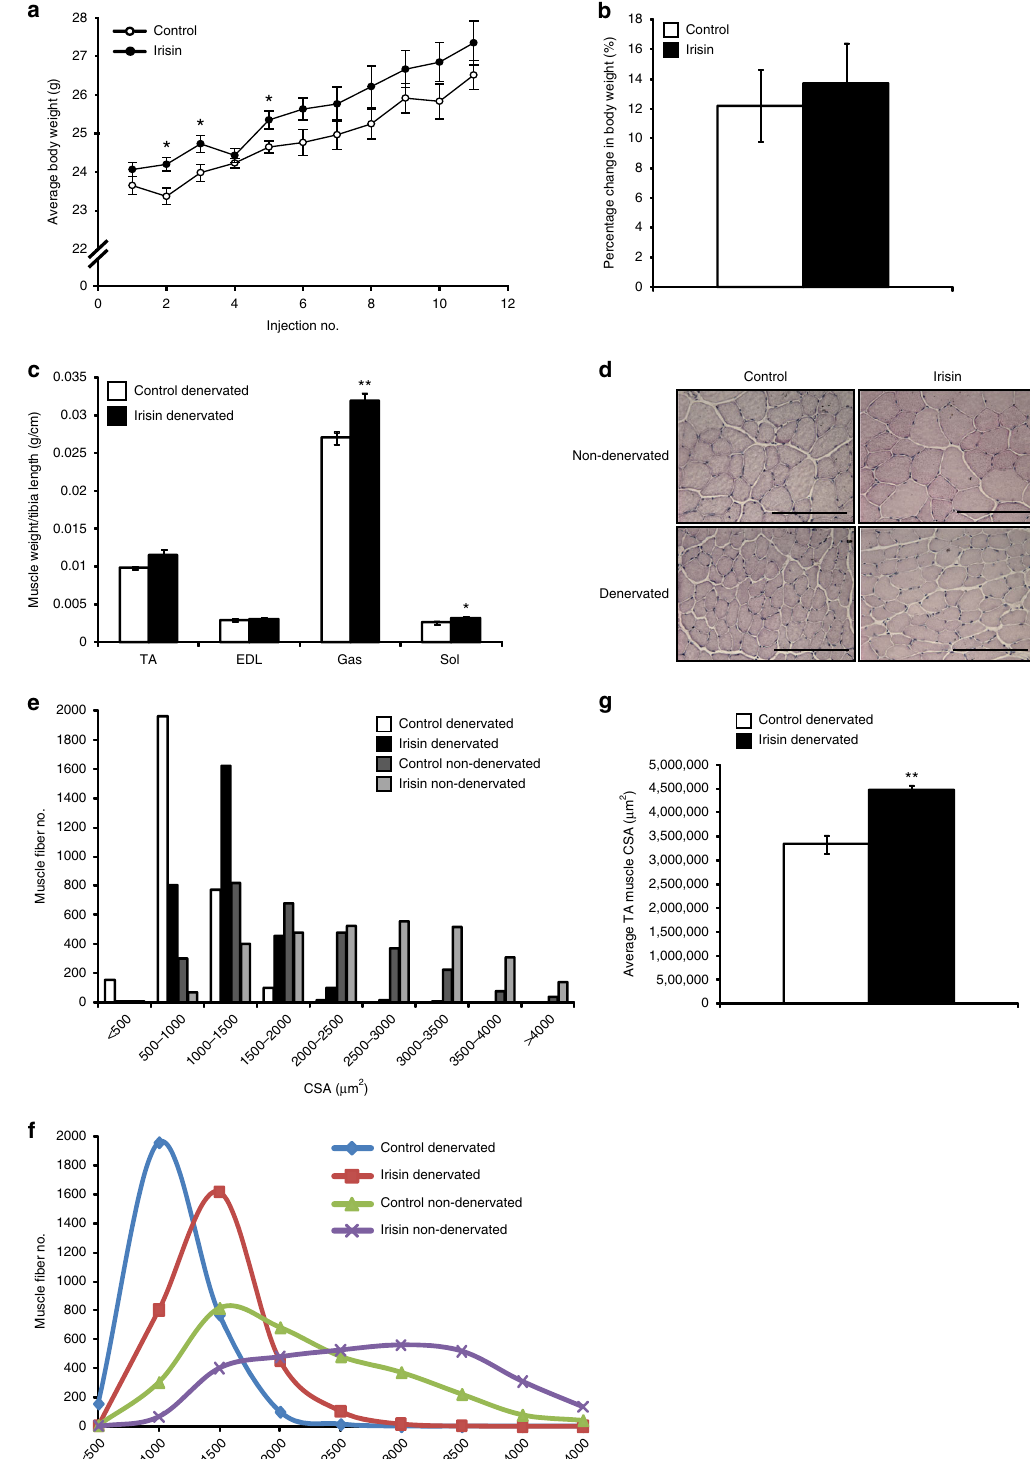
fi bers from 5 random fi elds (1000 fi bers per section per mouse) were analyzed ( n = 3 mice per treatment group). Immunohistochemical staining of muscle sections . Muscle sections were fi xed with 4% paraformaldehyde in phosphate-buffered saline (PBS) (pH 7.4) for 10 min and then permeabilized with 0.1% Triton X-100 for 10min. Sections were blocked